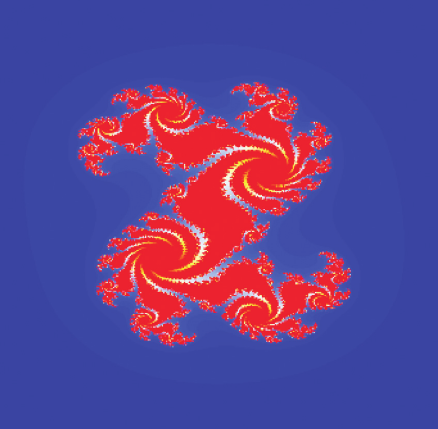
Figure 1: Quadratic Julia set in JSOmhh.